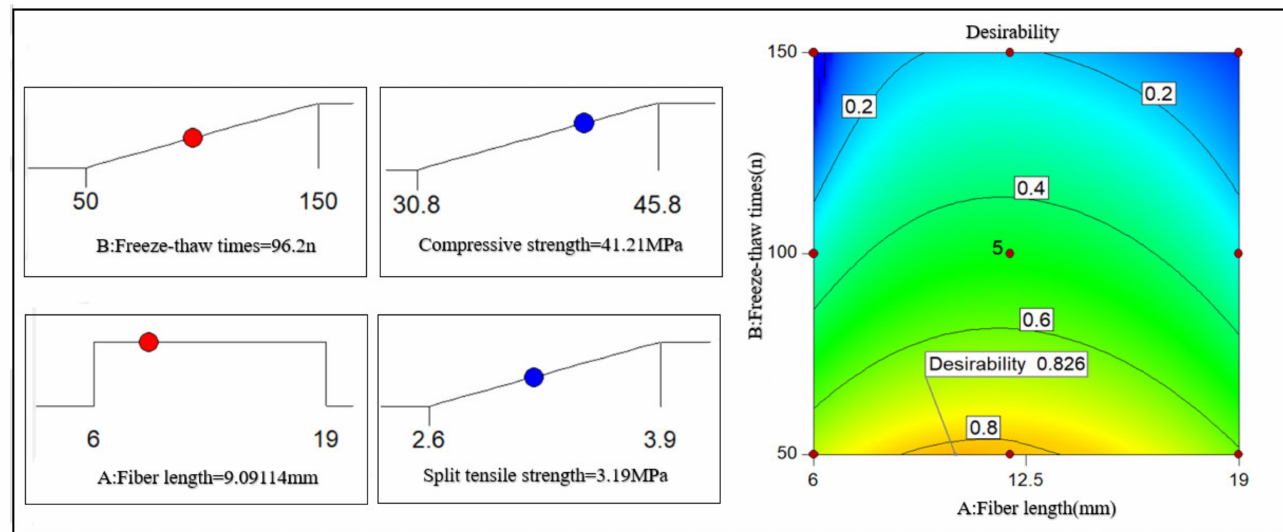
Figure 10. PFNSC and optimization results of strength maximization.